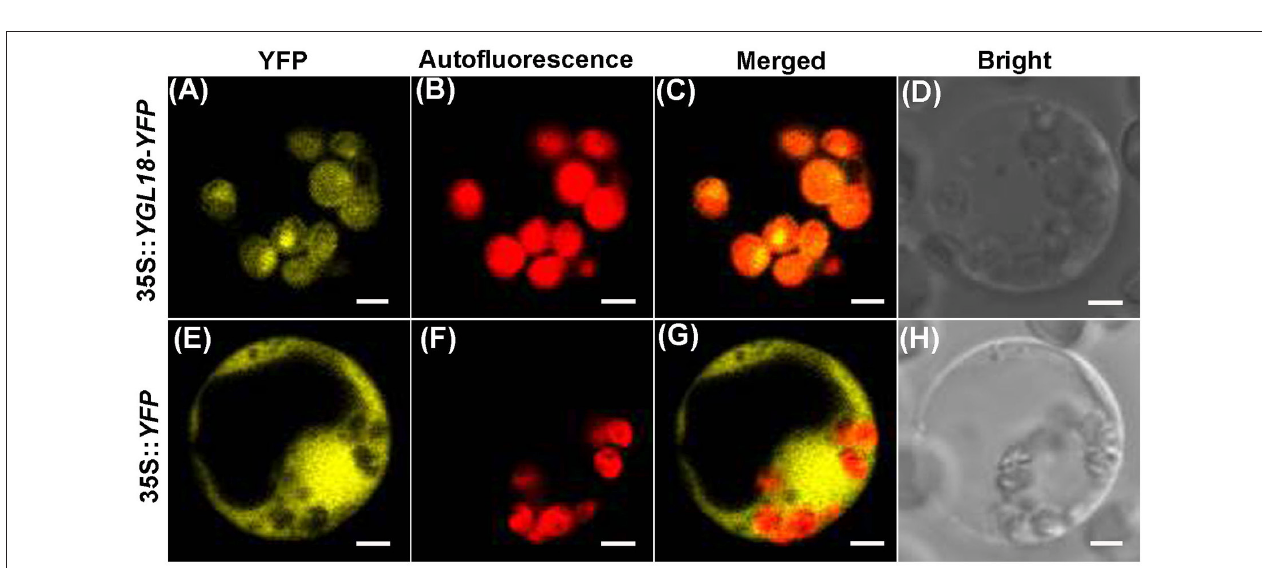
FIGURE 3 | Expression analysis of YGL18 by qRT-PCR. (A) Expression patterns of YGL18 in root, leaf, stem and panicle of the wild type and ygl18 mutant. Root and leaf were sampled from 15-day-old plants, while stem and panicle were sampled from 130-day-old plants. (B) Expression patterns of YGL18 in the newest fully expanded leaves of wild-type and ygl18 mutant plants at different days after germination. (C) Expression patterns of YGL18 in the first, second, and third fully expanded leaves of the wild-type and ygl18 mutant plants at about 90 days after germination. Expression levels of YGL18 in the leaf of wild type (A) , the 15-day-old leaf of wild type (B) , and the first leaf of wild type (C) , were respectively normalized to 1. Data represent the mean ± SD of three or four biological replicates (one-way ANOVA analysis). Different letters indicate values are statistically different based on a one-way ANOVA analysis.